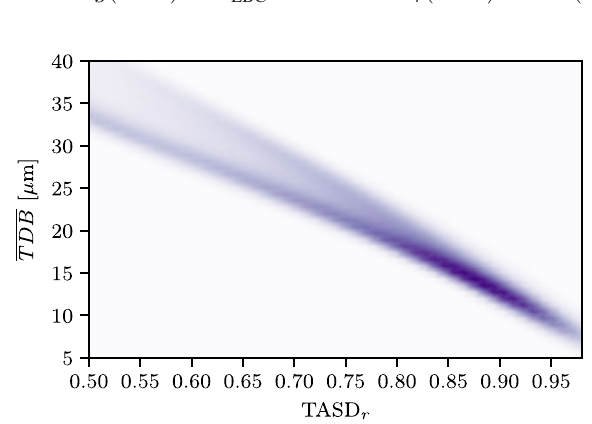
FIG. 36. Computed γ -ray relative TASD at the plane z ¼ 0 μ